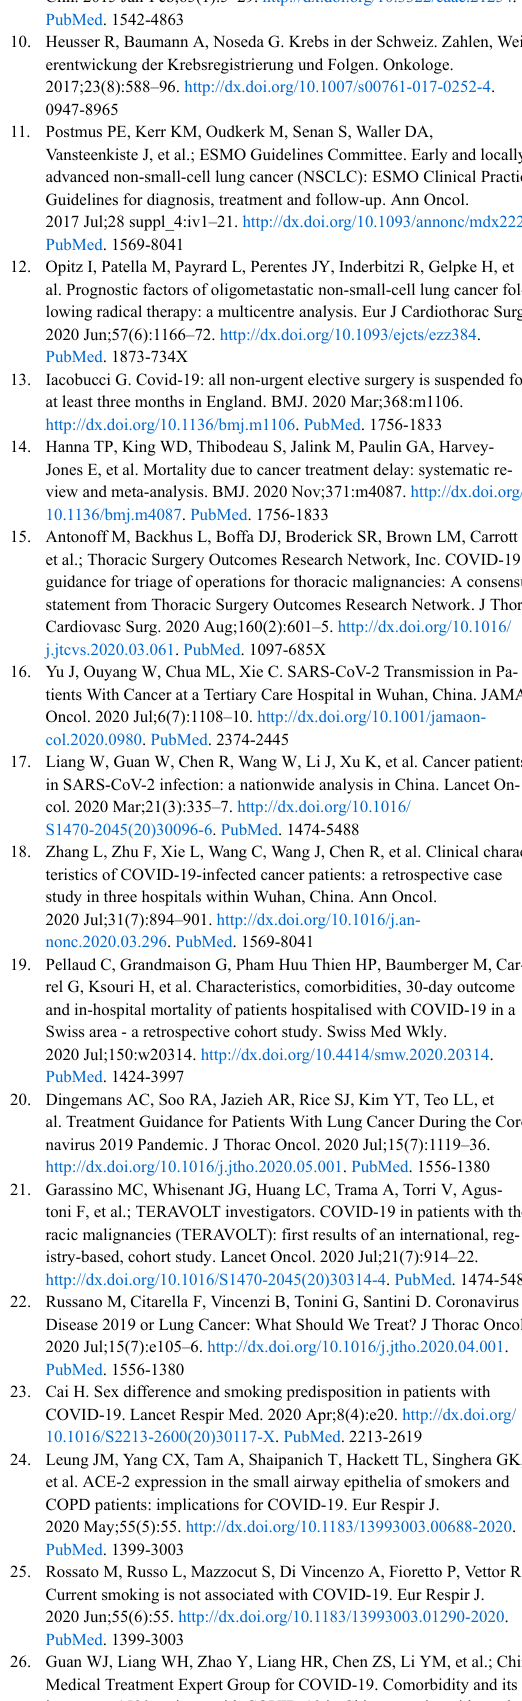
Table 4: COVID-19 status. COVID-19 status n = 50 COVID-19 Symptoms Fever 2 (4%) Cough 3 (6%) Shortness of breath 1 (2%) Loss of smell /taste 0 (0%) Fatigue 0 (0%) Postoperative COVID-19 test performed 25 (50%) Positive